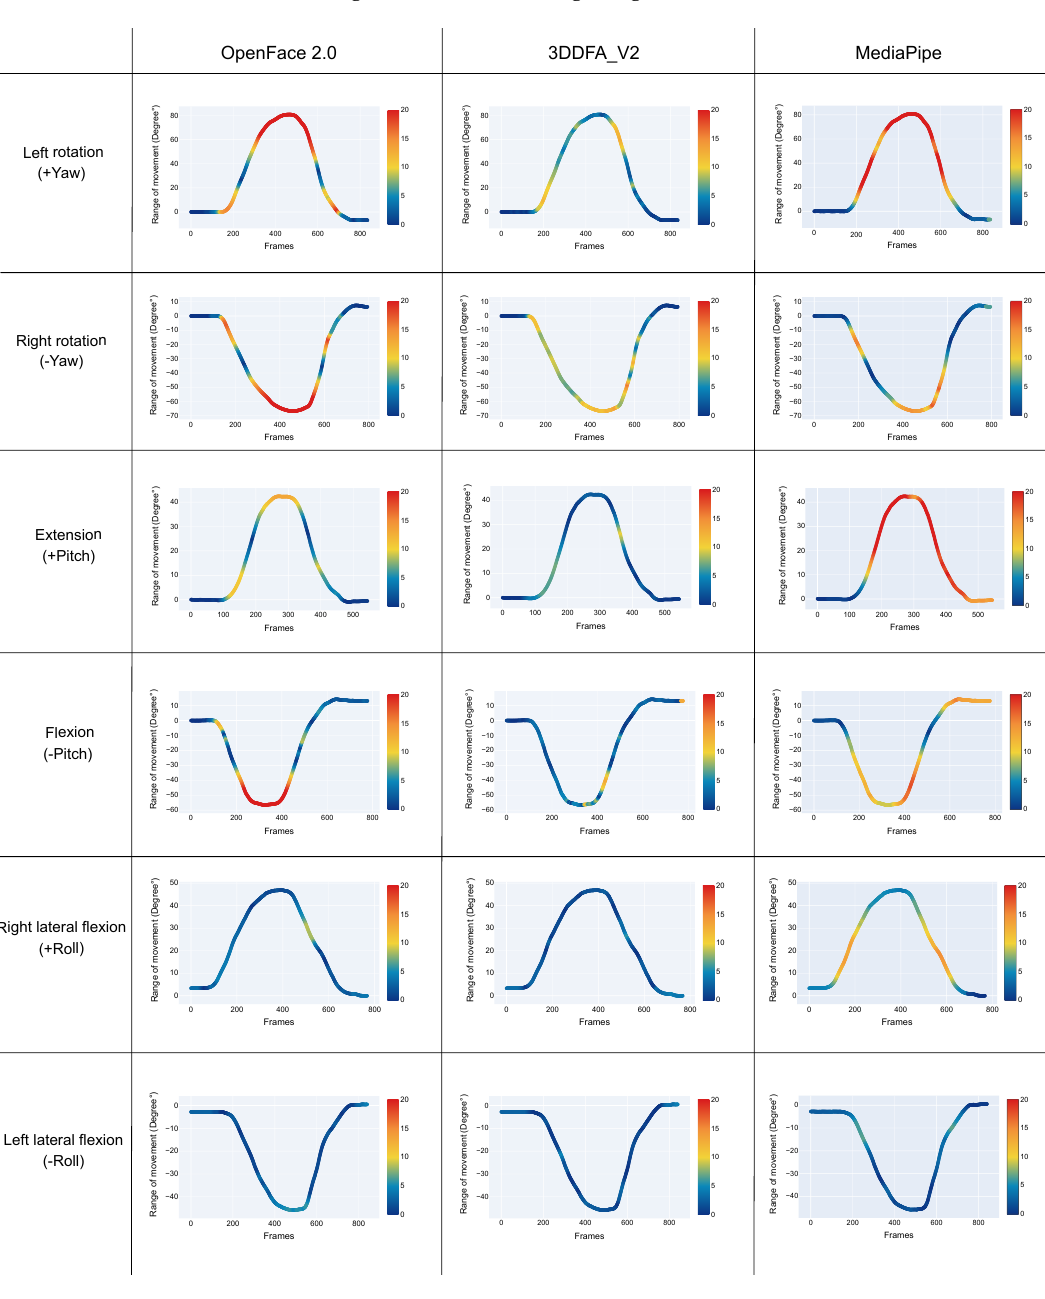
Figure 3. Accuracy variation results during head movements. Each panel represents the movement captured by the gold standard, per plane of motion. The absolute error assessed by each method is shown with the color of the curve: dark blue corresponds to a 0 ◦ error, dark red to an error greater or equal to 20 ◦